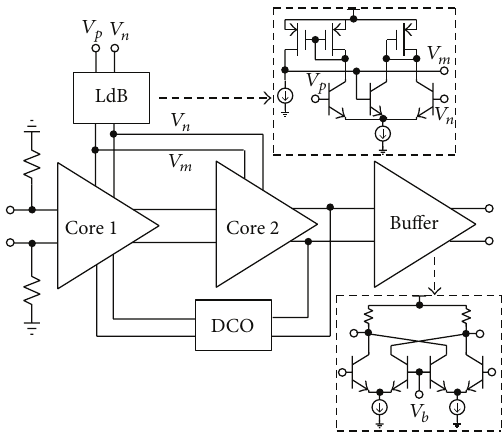
Figure 8: Block diagram of proposed VGA system.